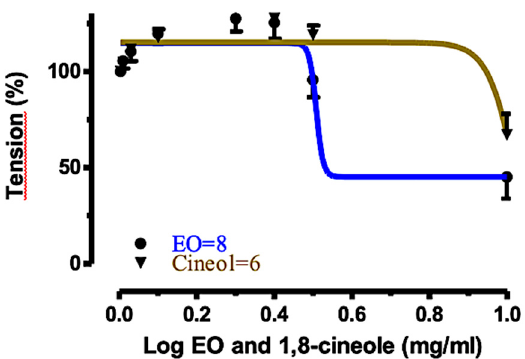
Figure 3. Concentration–response curves for the relaxant effects of 1,8-cineole ( 1 ) and EO S on rat tracheal rings, precontracted with ACh (10 µ M).